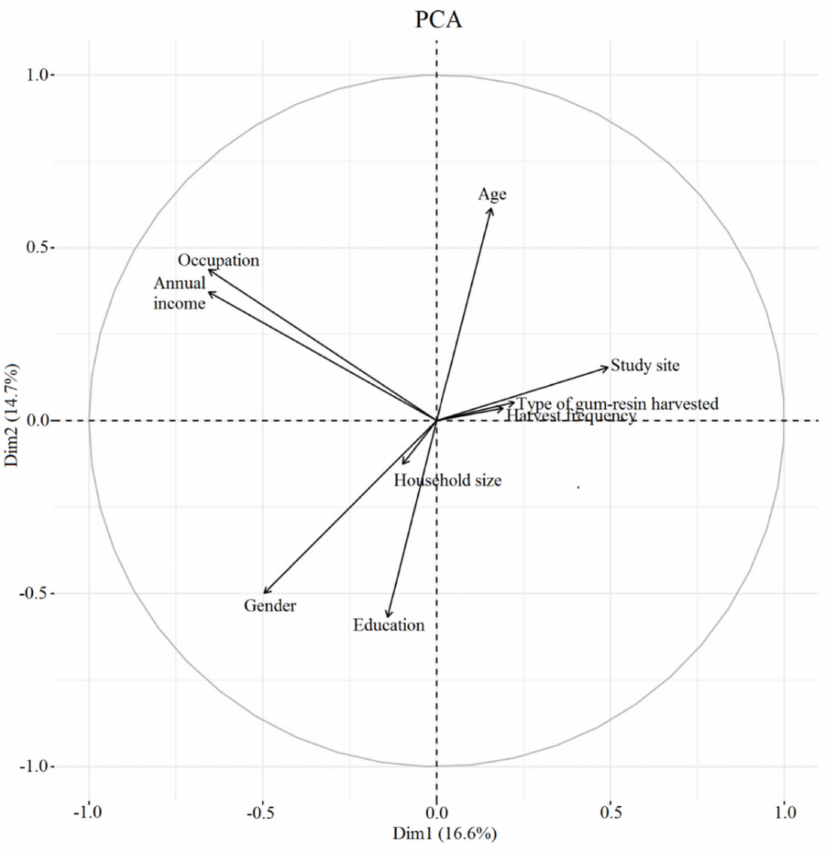
Figure 5. PCA (principal component analysis) demonstrating an association between harvester socio-economic profiles and harvesting